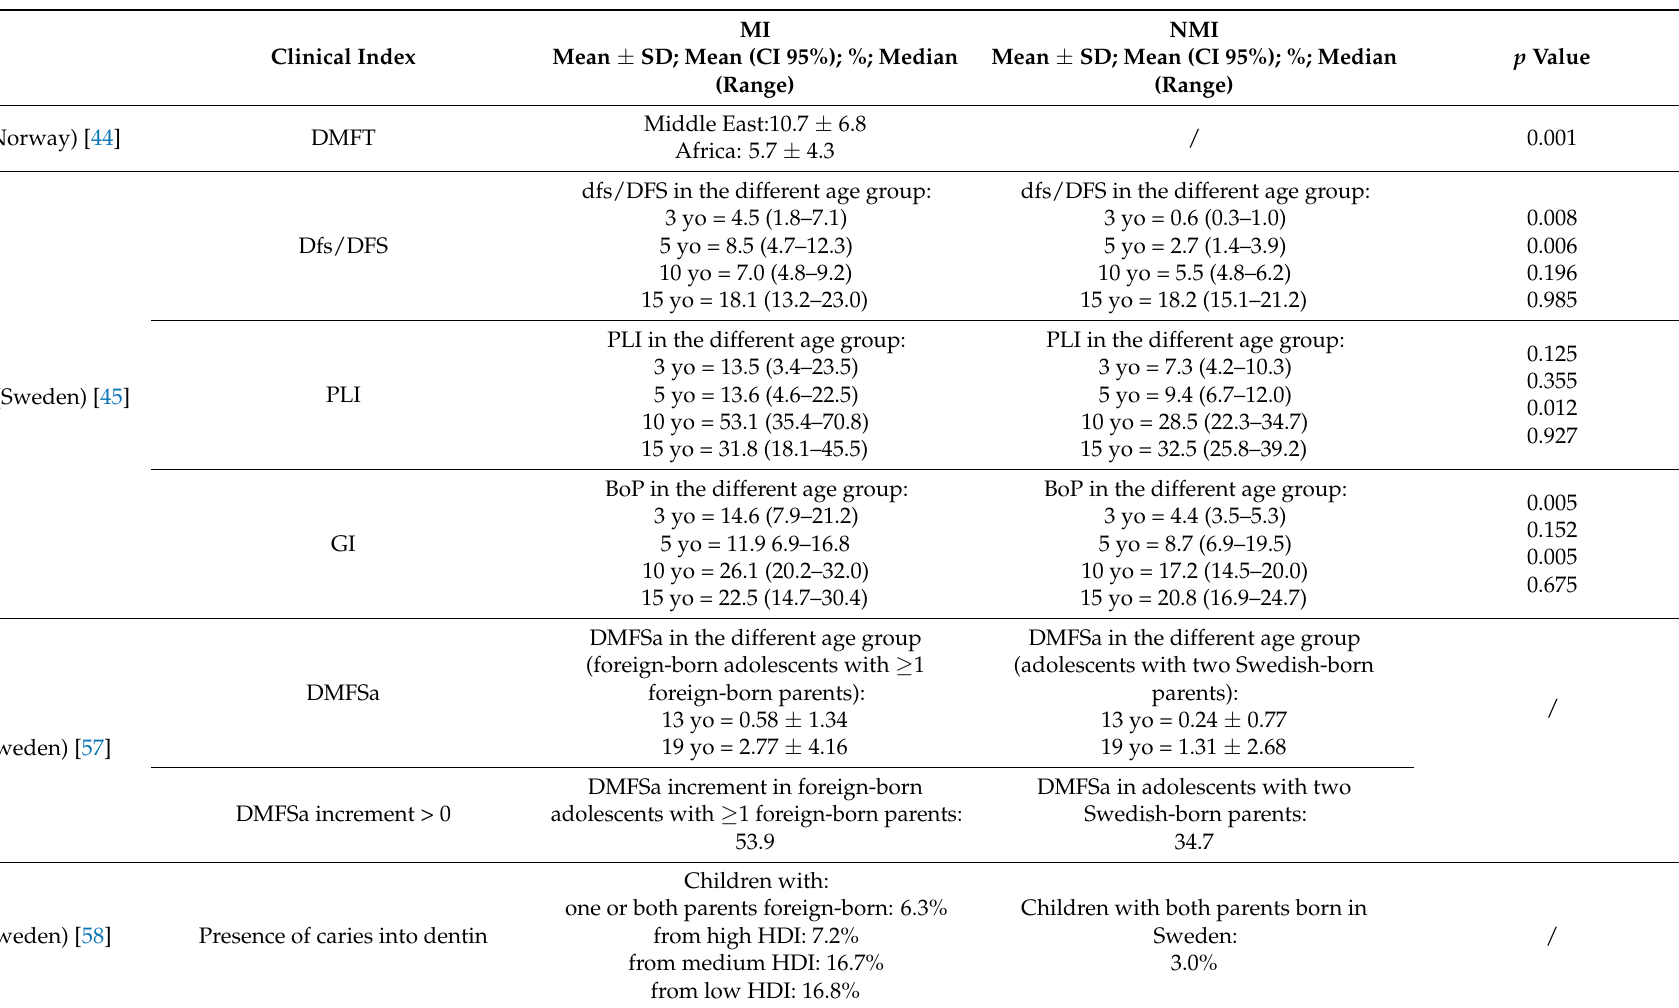
Table 15. Dental caries and periodontal status in MI and NMI living Norway and